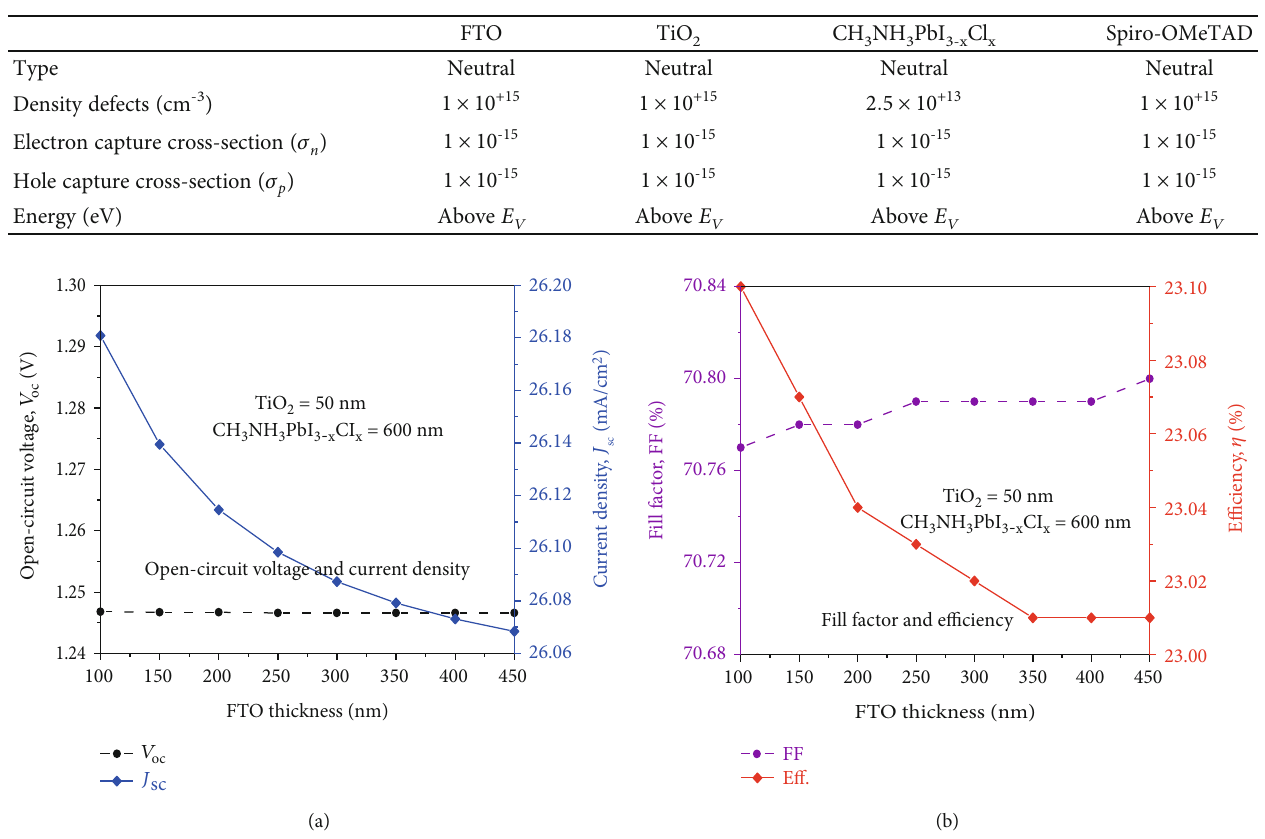
Table 2: The defect parameters for the Gaussian distribution.